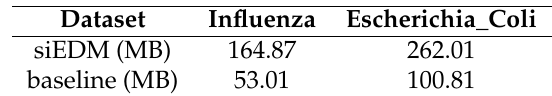
Table 5. Comparison of the memory consumption for the query search.